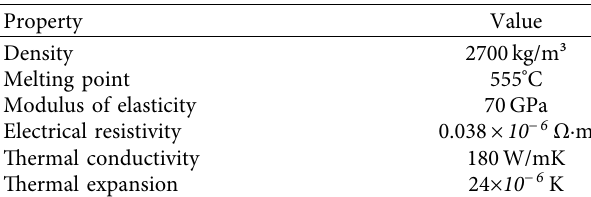
Table 2: Property of aluminium alloy 6082.